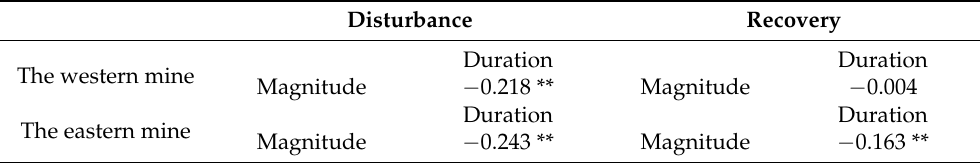
Table 4. Spearman’s correlation of the duration and